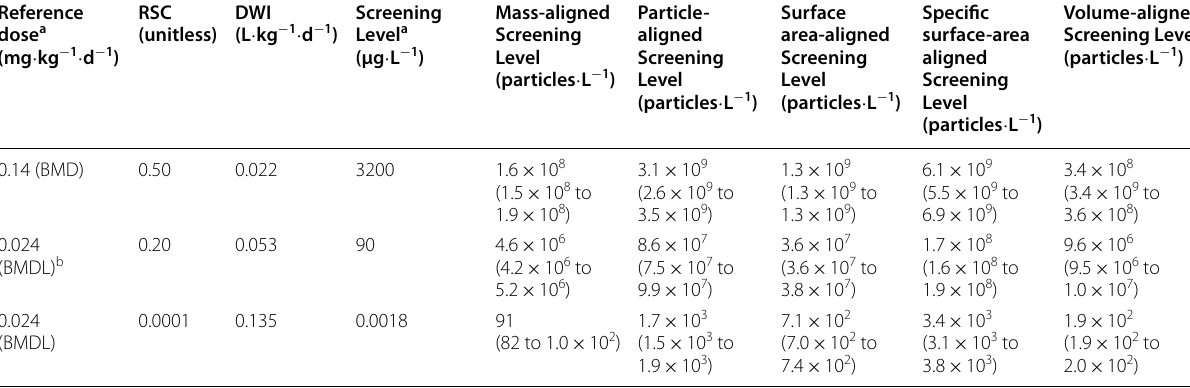
a Reference doses and screening levels reported here are derived with a composite uncertainty factor of one b ”Default” parameters for screening level derivation